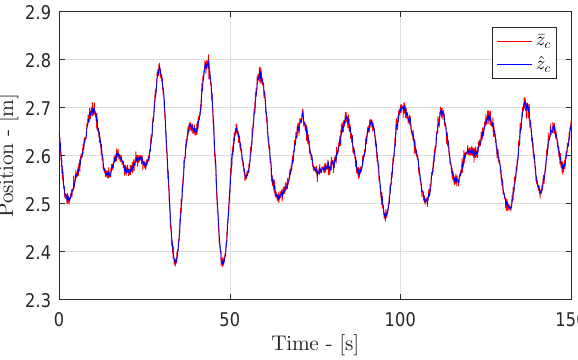
Figure 12: Positional comparison in the z-direction.